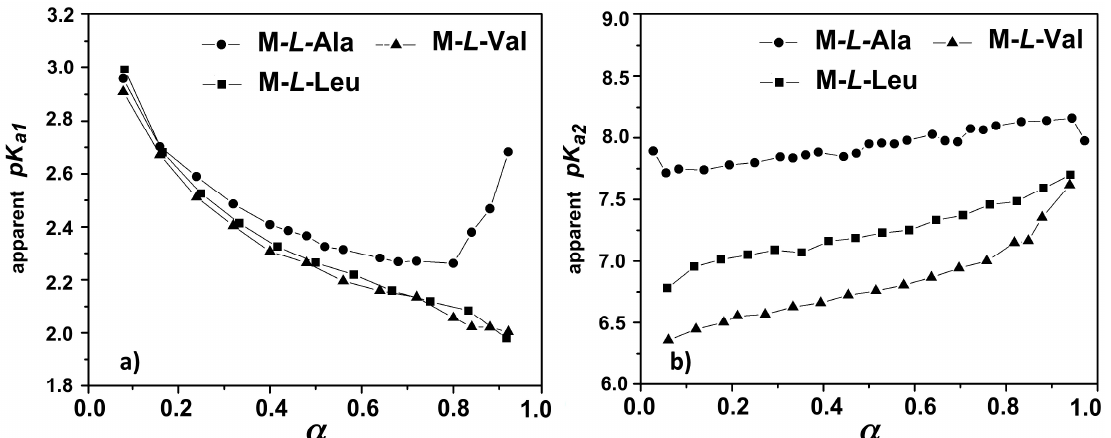
Figure 1. Dependence of PAAC apparent ( a ) carboxyl- and ( b ) amine pK a values on the dissociation degree. Operational conditions: 0.05 M repeating units in aqueous 0.1 M NaCl at 25 °C.